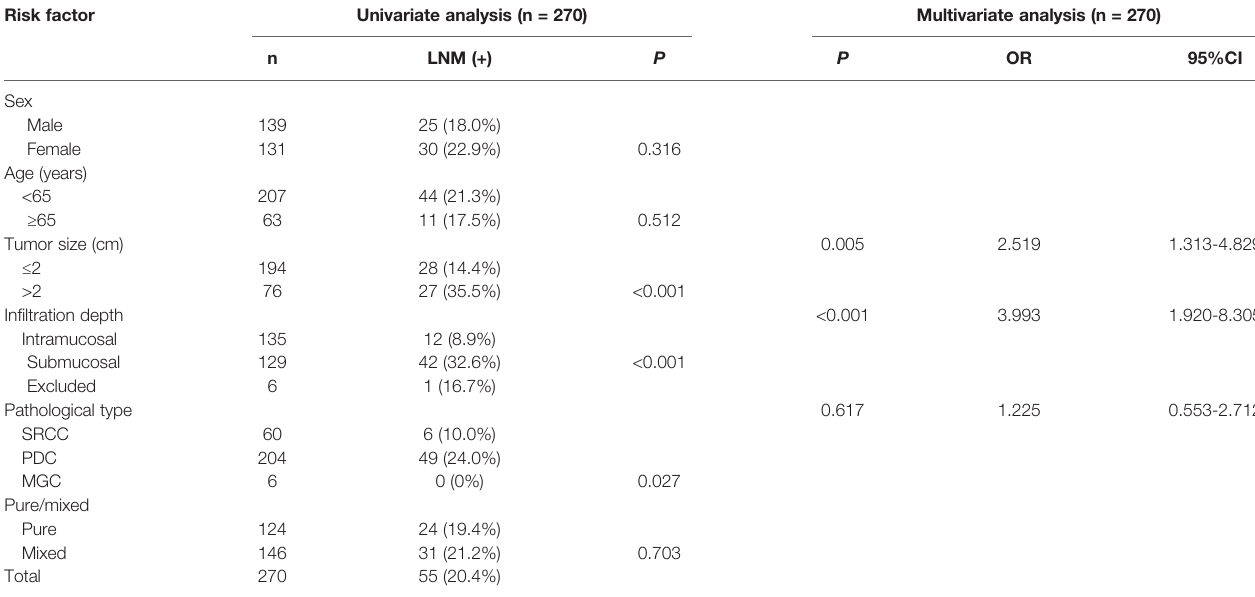
TABLE 6 | Univariate and multivariate analyses of the risk factors for lymph node metastasis in early undifferentiated gastric cancer. Risk factor Univariate analysis (n =